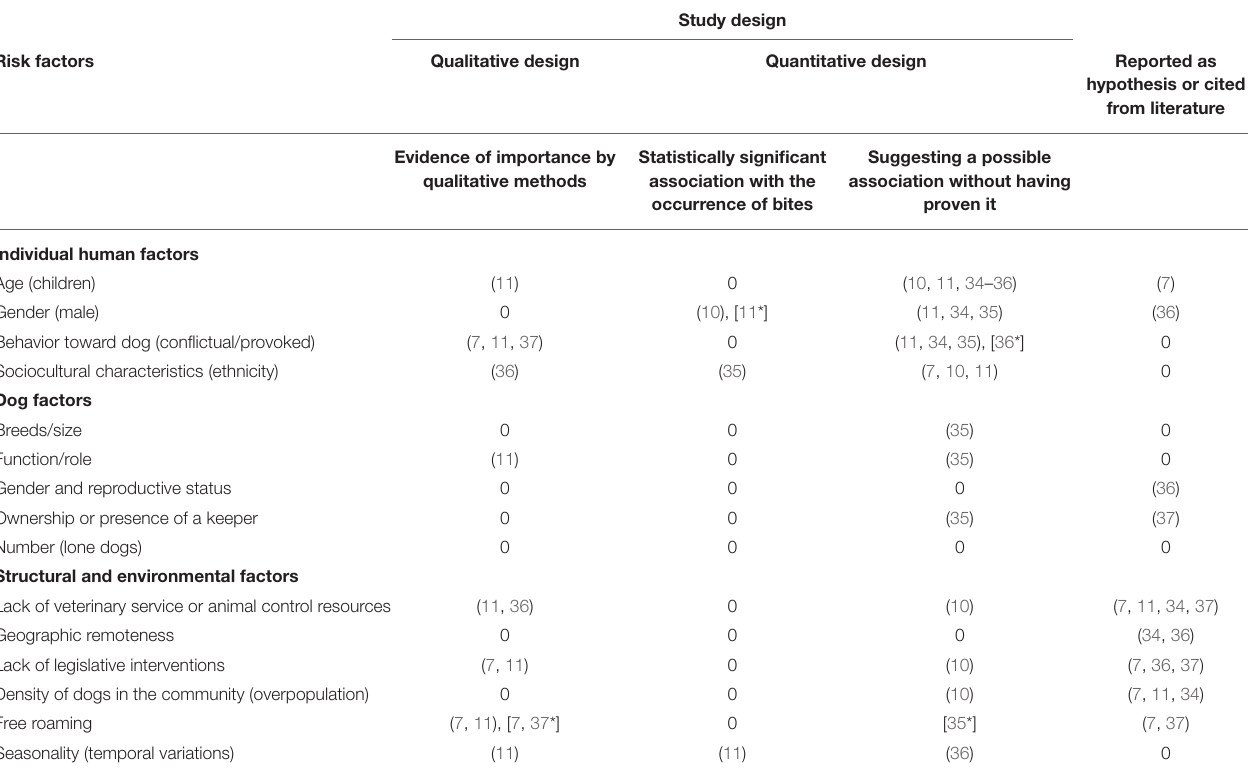
TABLE 4 | Dog bite risk factors identified by the studies included in the scoping review (some studies may have been classified in more than one